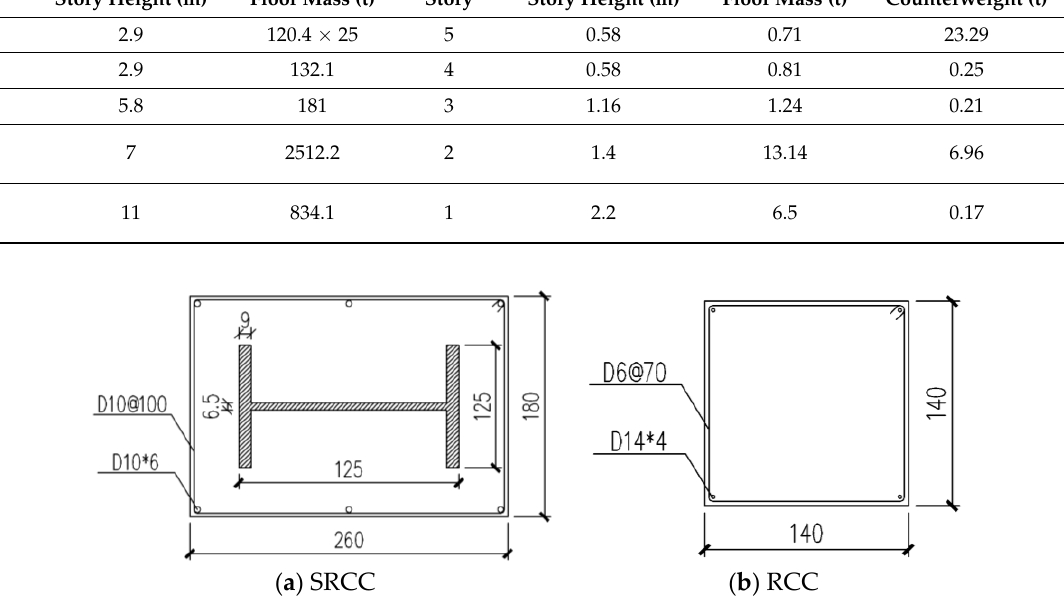
Figure 4. Column reinforcement diagram.